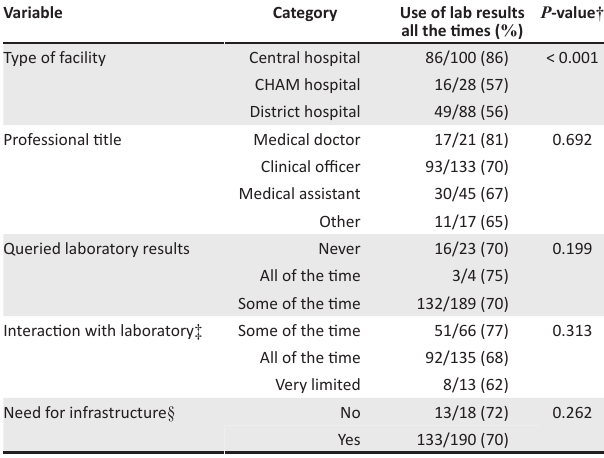
TABLE 5: Factors associated with use of laboratory results by clinicians in Malawi, October-November 2012. Variable